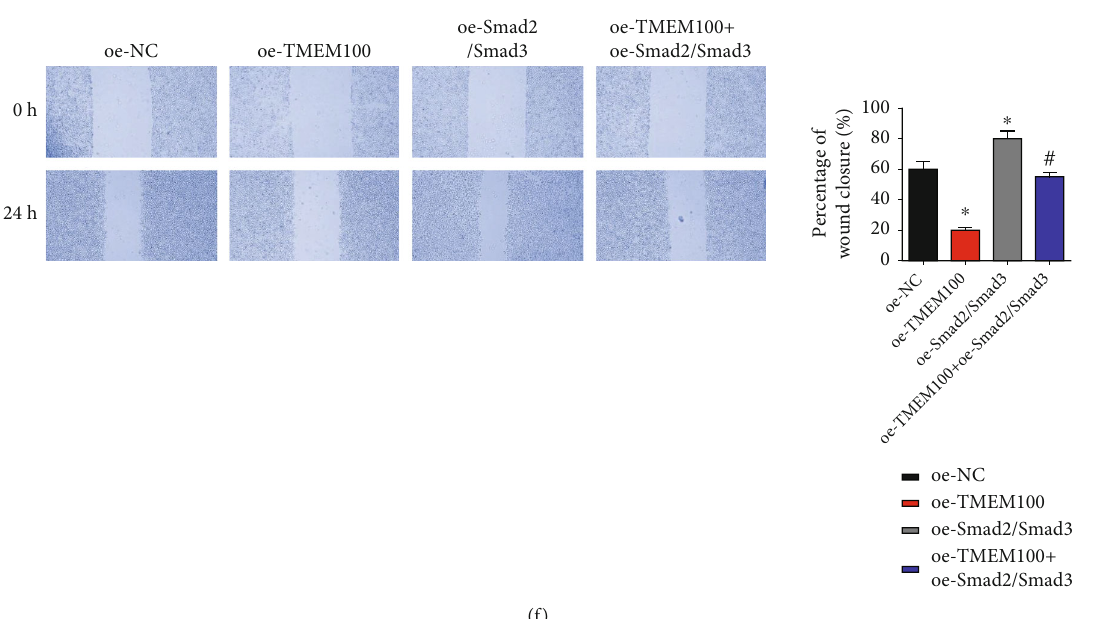
Figure 4: TMEM100 suppresses CRC cell growth by regulating TGF- β signaling pathway. (a) The signaling pathway regulated by TMEM100 was analyzed by GSEA. (b) Western blot assessed the expression of TGF- β signaling-related proteins upon TMEM100 overexpression. The proliferative, colony formative, invasive, and migratory abilities of NCI-H498 cells were determined by conducting (c) MTT assay, (d) colony formation assay, (e) Transwell assay, and (f) scratch healing assay upon simultaneously overexpressing Smad2/Smad3 and TMEM100. ∗ Compared with oe-NC, p < 0 : 05 ; # compared with oe-Smad2/Smad3, p < 0 : 05